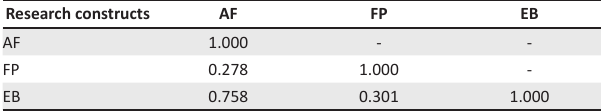
TABLE 3: Inter-construct correlation